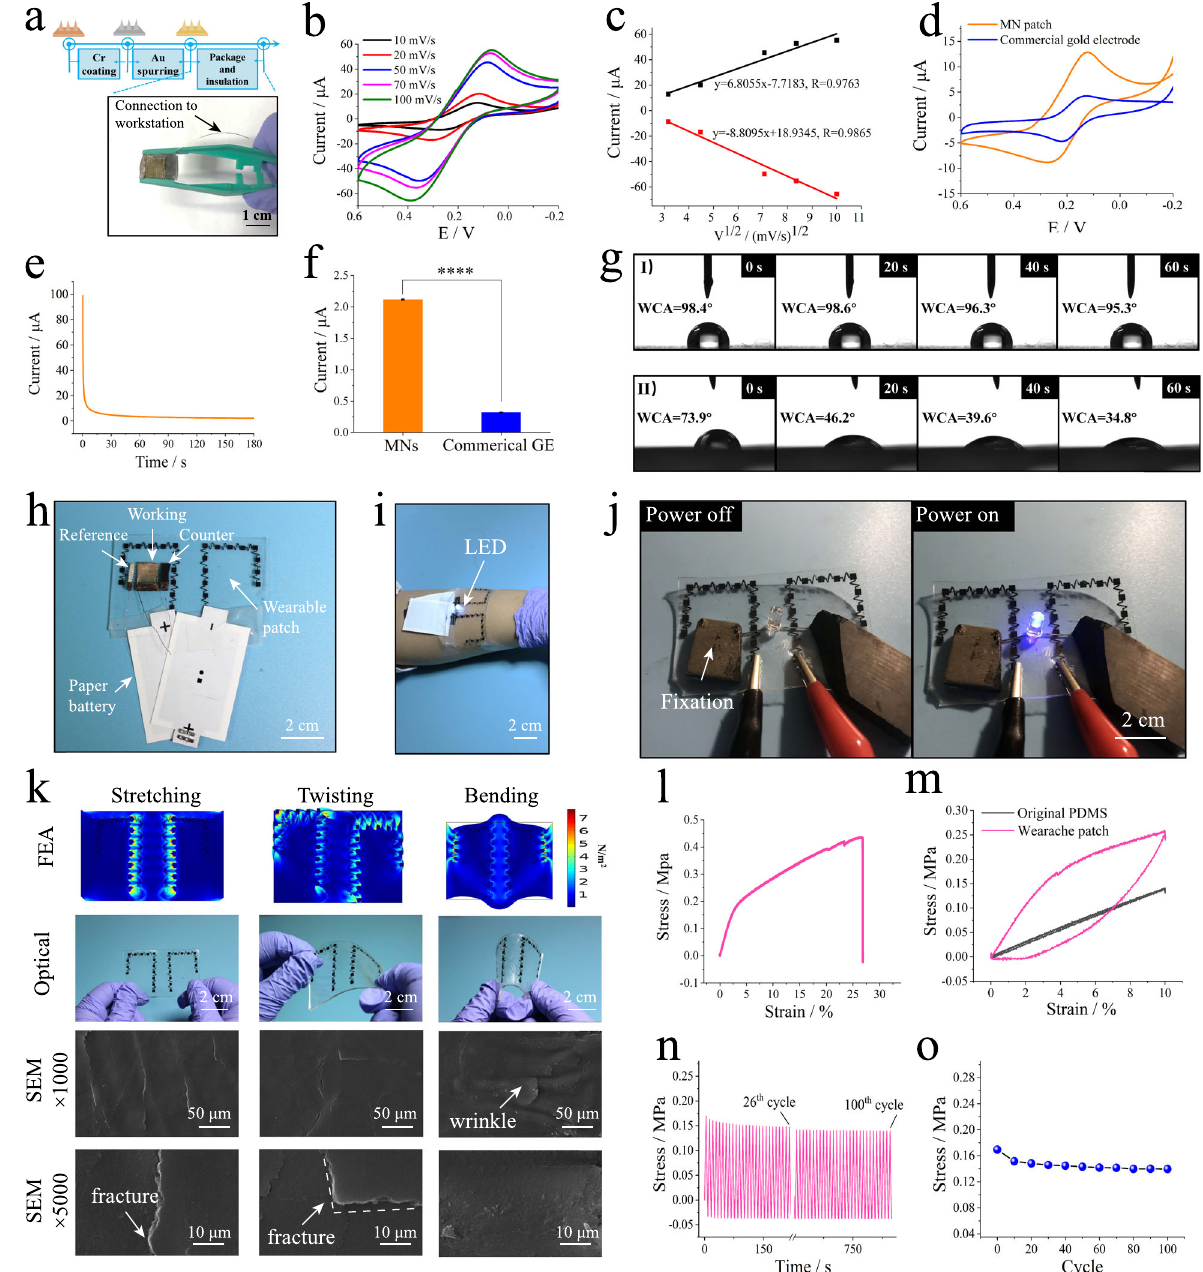
Fig. 3 Fabrication, electrochemical and mechanical properties of the CRISPR wearable patch. a Schematic illustration of the conductive MNs. b CV plots of the as-fabricated conductive MNs under different scanning rates, using a 1 mM [Fe(CN) 6 ] 3 − /4 − probe; quiet time, 2 s; sensitivity (A/V), 1 × 10 − 4 A/V. c The relationship between the square root of the scanning rate and the corresponding peak current using a 1 mM [Fe(CN) 6 ] 3 − /4 − probe; quiet time, 2 s; sensitivity (A/V), 1 × 10 − 4 A/V. d CV plots of the conductive MNs and commercial gold electrode using a 1 mM [Fe(CN) 6 ] 3 − /4 − probe; quiet time, 2 s; sensitivity (A/V), 1 × 10 − 4 A/V. e Real-time i – t curve recorded by the conductive MNs in PBS buffer (0.01 M, pH 7.4); quiet time, 0 s; sensitivity (A/V), 1 × 10 − 3 A/V. f The real-time current of the conductive MNs and commercial gold electrode in PBS buffer (0.01 M, pH 7.4); * p < 0.05, ** p < 0.01, *** p < 0.001, **** p < 0.0001, analyzed by two-way ANOVA, p value of 0.0000094, quiet time, 0 s; sensitivity (A/V), 1 × 10 − 3 A/V. g Contact angle testing of water droplets on the surface of the (I) original PDMS fi lm and (II) hydrophilic-treated PDMS fi lm. h Photograph of the CRISPR wearable patch based on reverse iontophoresis and three-electrode MNs. i The printed wearable patch mounted on skin. j A blue LED powered by the wearable patch with a voltage of 6 V. k Finite elemental analysis, optical photographs, and SEM of the wearable device under different mechanical distortions, including stretching, twisting, and bending; the results obtained from three independent repeated experiments. l Strain versus stress curve for the wearable patch. m A single stretch-release cycle with 10% strain for two different membranes. n Stress variation of the wearable patch in a 100-cycle test with a strain of 4%. o Stress changes of the wearable patch every ten